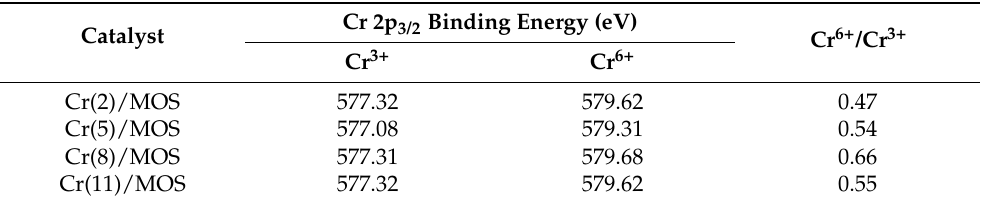
Table 2. XPS data of Cr(x)/MOS (x = 2, 5, 8 and 11 wt.%) catalysts.